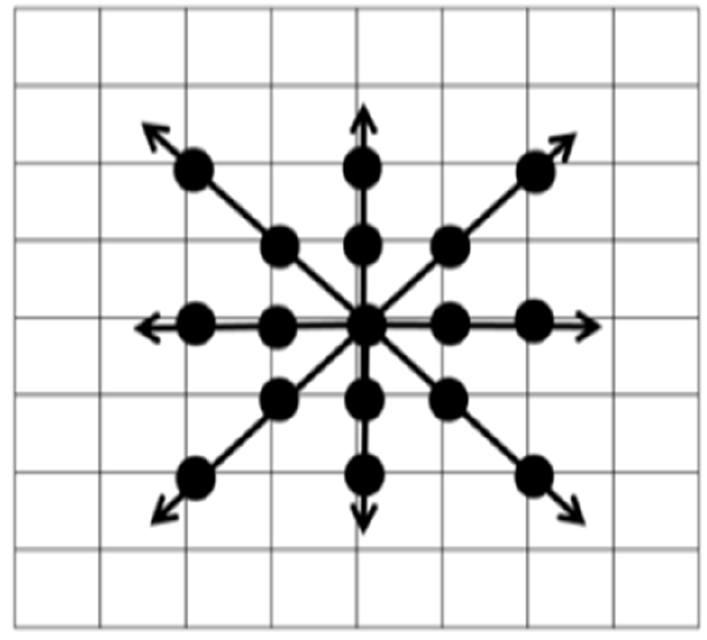
Figure 5. The All-Directional Search (ADS) pattern.